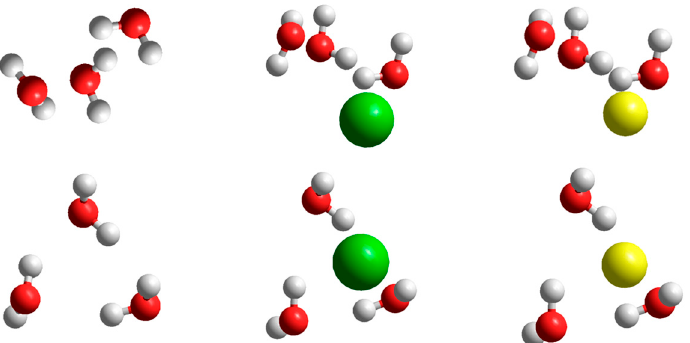
Figure 5. Side (top row) and top (bottom row) of the optimized structures of (H 2 O) 9 clusters (left), (H 2 O) 9 clusters with potassium ion (middle) and (H 2 O) 9 clusters with sodium ion (right).